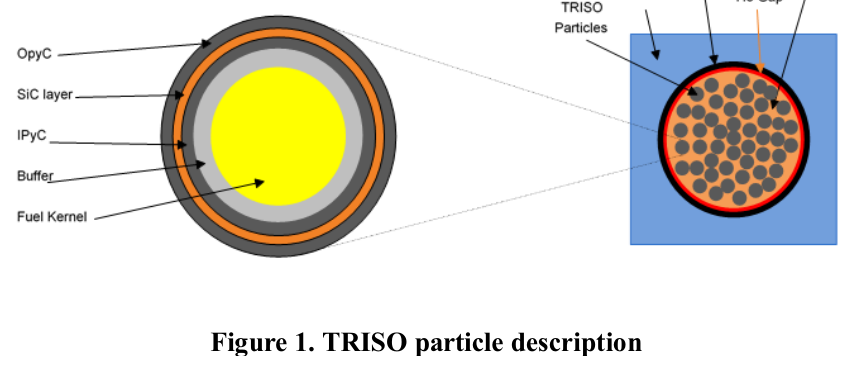
Figure 1. TRISO particle description